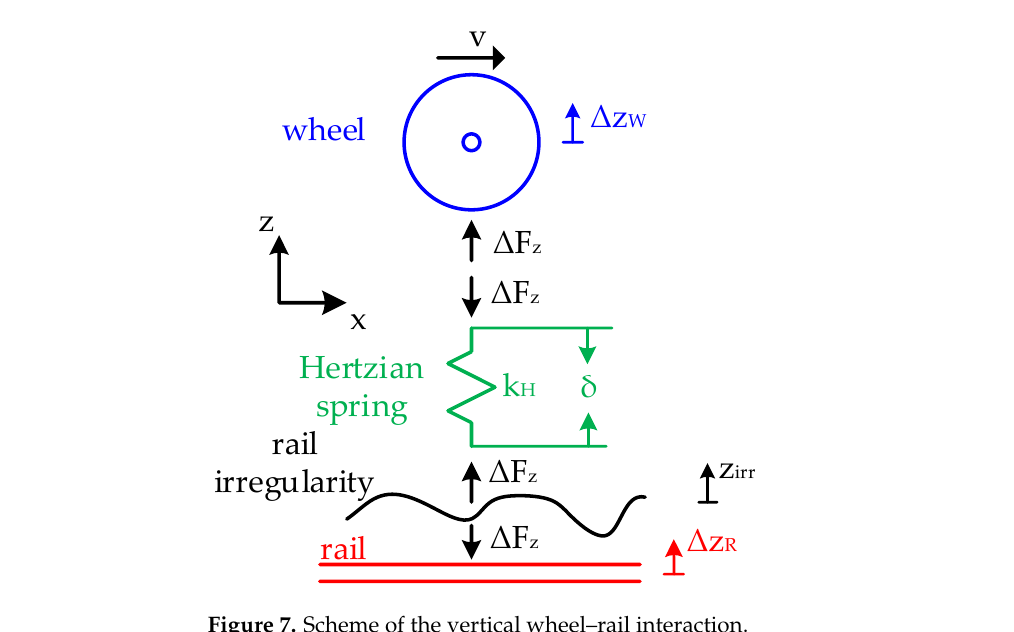
When discrete supports are considered, the receptance is calculated at different positions along the span between two supports.